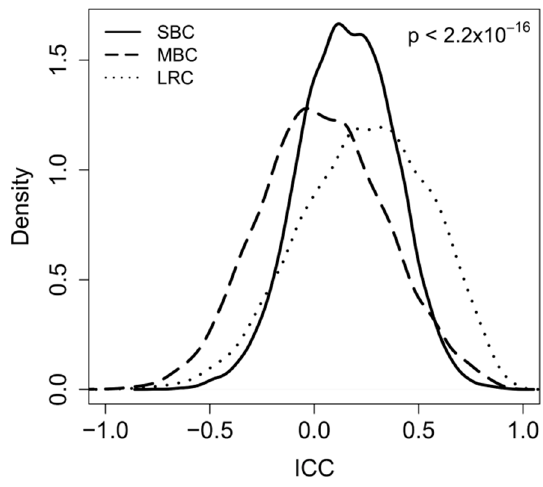
Figure 2. Distribution of intraclass correlation coefficient (ICC) values calculated for each single gene for tumor pairs derived from women with metachronous (MBC), synchronous (SBC), and locally relapsed (LCR) breast cancer. Only the 8586 most variable genes (IQR > 0.5) were used. Differences in the ICC distributions in the three groups (SBC; MBC; and, LRC) were tested using analysis of variance (ANOVA). p < 2.2 × 10 -16 .